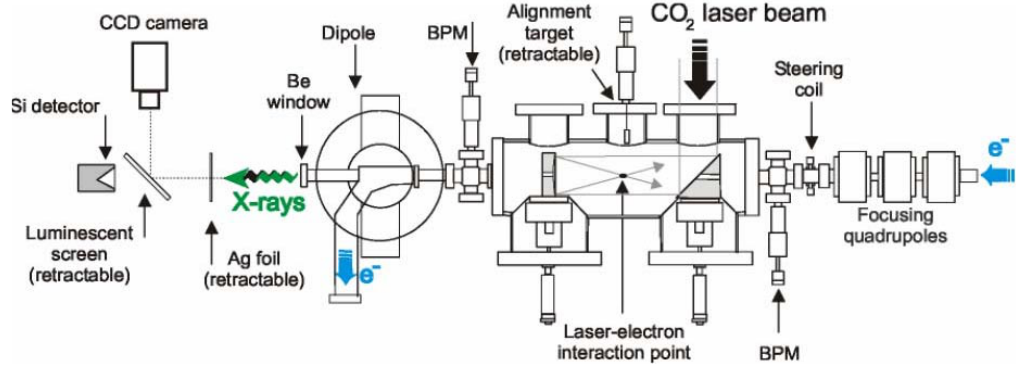
FIG. 1. (Color) Principle diagram of the BNL-ATF Thomson scattering